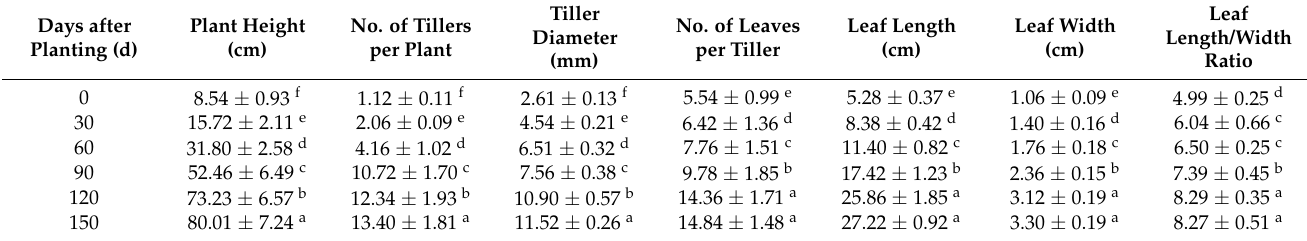
Table 2. Morphological indexes of the disease-free plants of ginger at different periods after